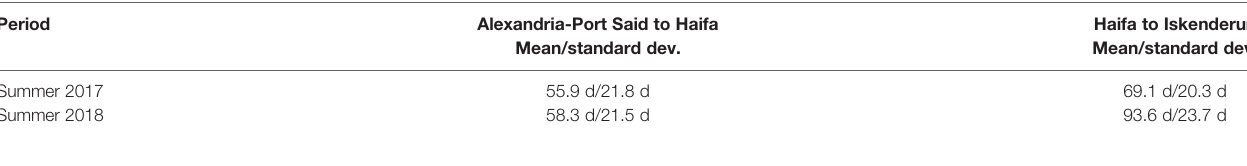
TABLE 2 | Mean and standard deviation of drift times to and from Haifa from simulations. Period Haifa to Iskenderun Mean/standard